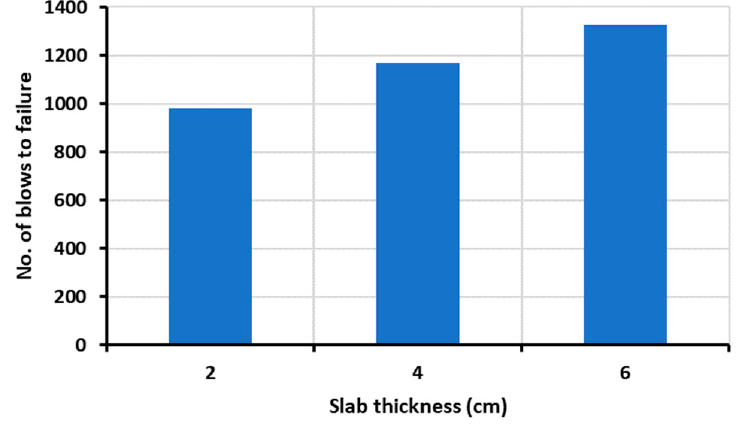
Figure 11. The relationship between the number of blows to slab failure and thickness of SIFCON slabs with hybrid steel fibres.